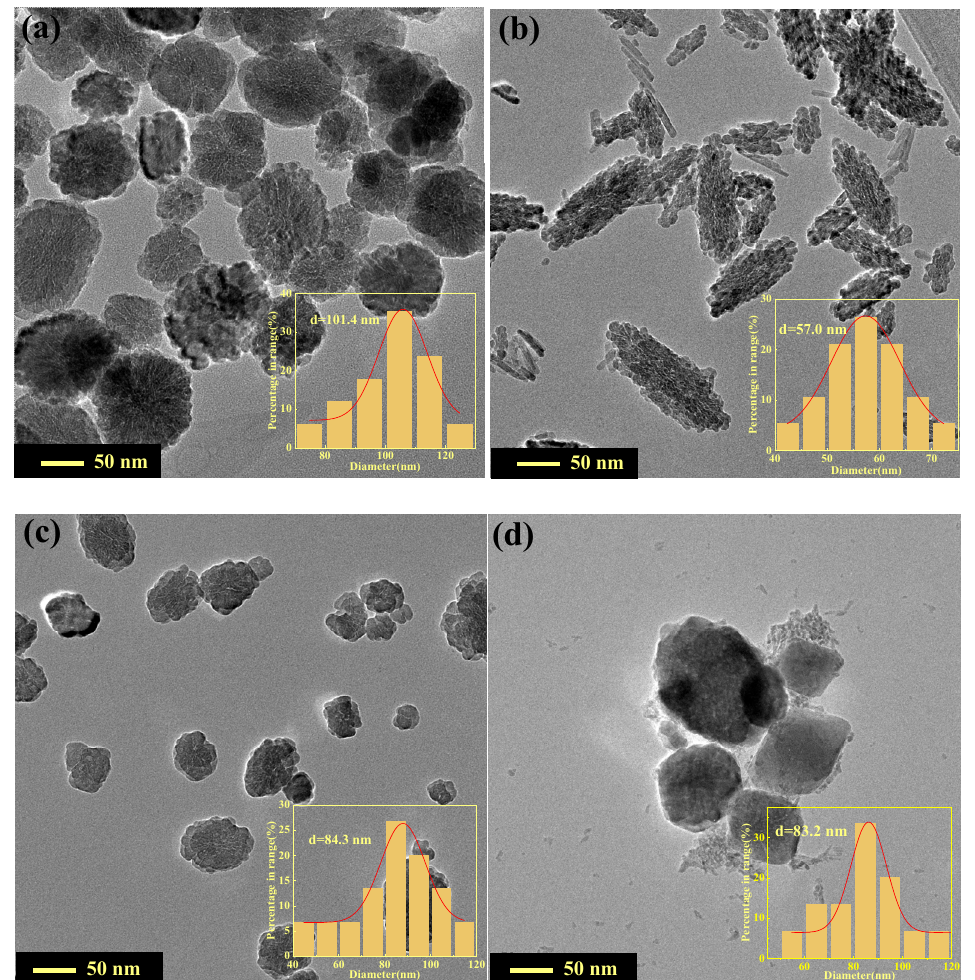
Figure 2. TEM images of α -Fe 2 O 3 (u) and La-doped α -Fe 2 O 3 (x) (x = 4, 6, 8). a α -Fe 2 O 3 (u); ( b ) La-doped α -Fe 2 O 3 (4); ( c ) La-doped α -Fe 2 O 3 (6); ( d ) La-doped α -Fe 2 O 3 (8). Figure 3 shows the high-resolution TEM images and selected area electron diffraction patterns of α -Fe 2 O 3 (u) and La-doped α -Fe 2 O 3 (x) (x = 4, 6, 8). For α -Fe 2 O 3 (u), the d-spacing value of 0.271 nm is assigned to the (104) crystal plane of α -Fe 2 O 3 (Figure 3a). For La-doped α -Fe 2 O 3 (4), the d-spacing values of 0.374 nm and 0.273 nm are assigned to the (012) and (104) crystal plane of the α -Fe 2 O 3 , which are 0.006 nm and 0.003 nm larger than JCPDS33–0664, respectively (Figure 3c). For La-doped α -Fe 2 O 3 (6), the d-spacing values of 0.254 nm and 0.275 nm are assigned to the (012) and (104) crystal plane of the α -Fe 2 O 3 , which are 0.002 nm and 0.005 nm larger than JCPDS33–0664, respectively (Figure 3e). For La-doped α -Fe 2 O 3 (8), the d-spacing values of 0.372 nm and 0.272 nm are assigned to the (012) and (104) crystal plane of the α -Fe 2 O 3 , which are 0.004 nm and 0.002 nm larger than JCPDS33–0664, respectively (Figure 3g). These results further prove that the La element is doped into the α -Fe 2 O 3 lattice, resulting in the α -Fe 2 O 3 lattice expansion. In addition, compared with La-doped α -Fe 2 O 3 (x)(x = 4, 8), the increase in (104) crystal plane spacing is more obvious in La-doped α -Fe 2 O 3 (6), indicating La doped α -Fe 2 O 3 (6) has the largest lattice